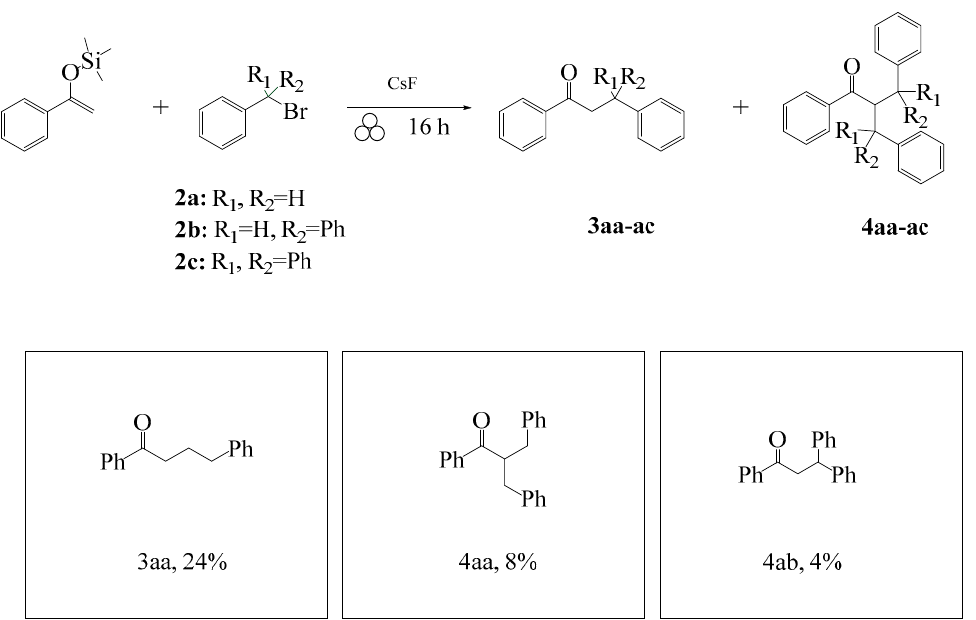
Figure 2. Silyl enol ether reactivity under mechanochemical conditions.